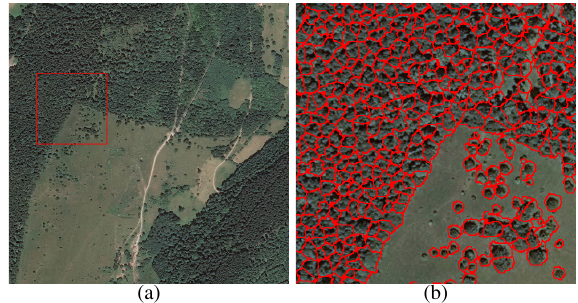
Figure 4. Result of the tree delineation. (a) Orthoimage (1km 2 ): the red square corresponds to the sub-area where the tree delin- eation results (b) are